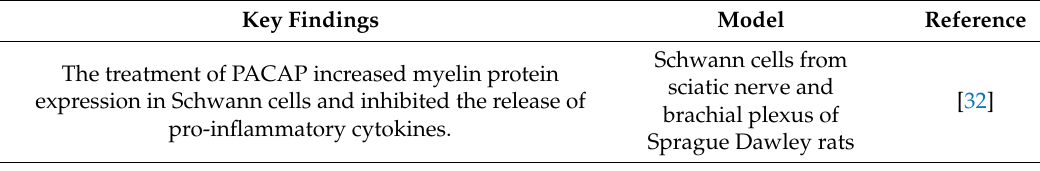
Table 1. Role of PACAP on Schwann cells during nerve